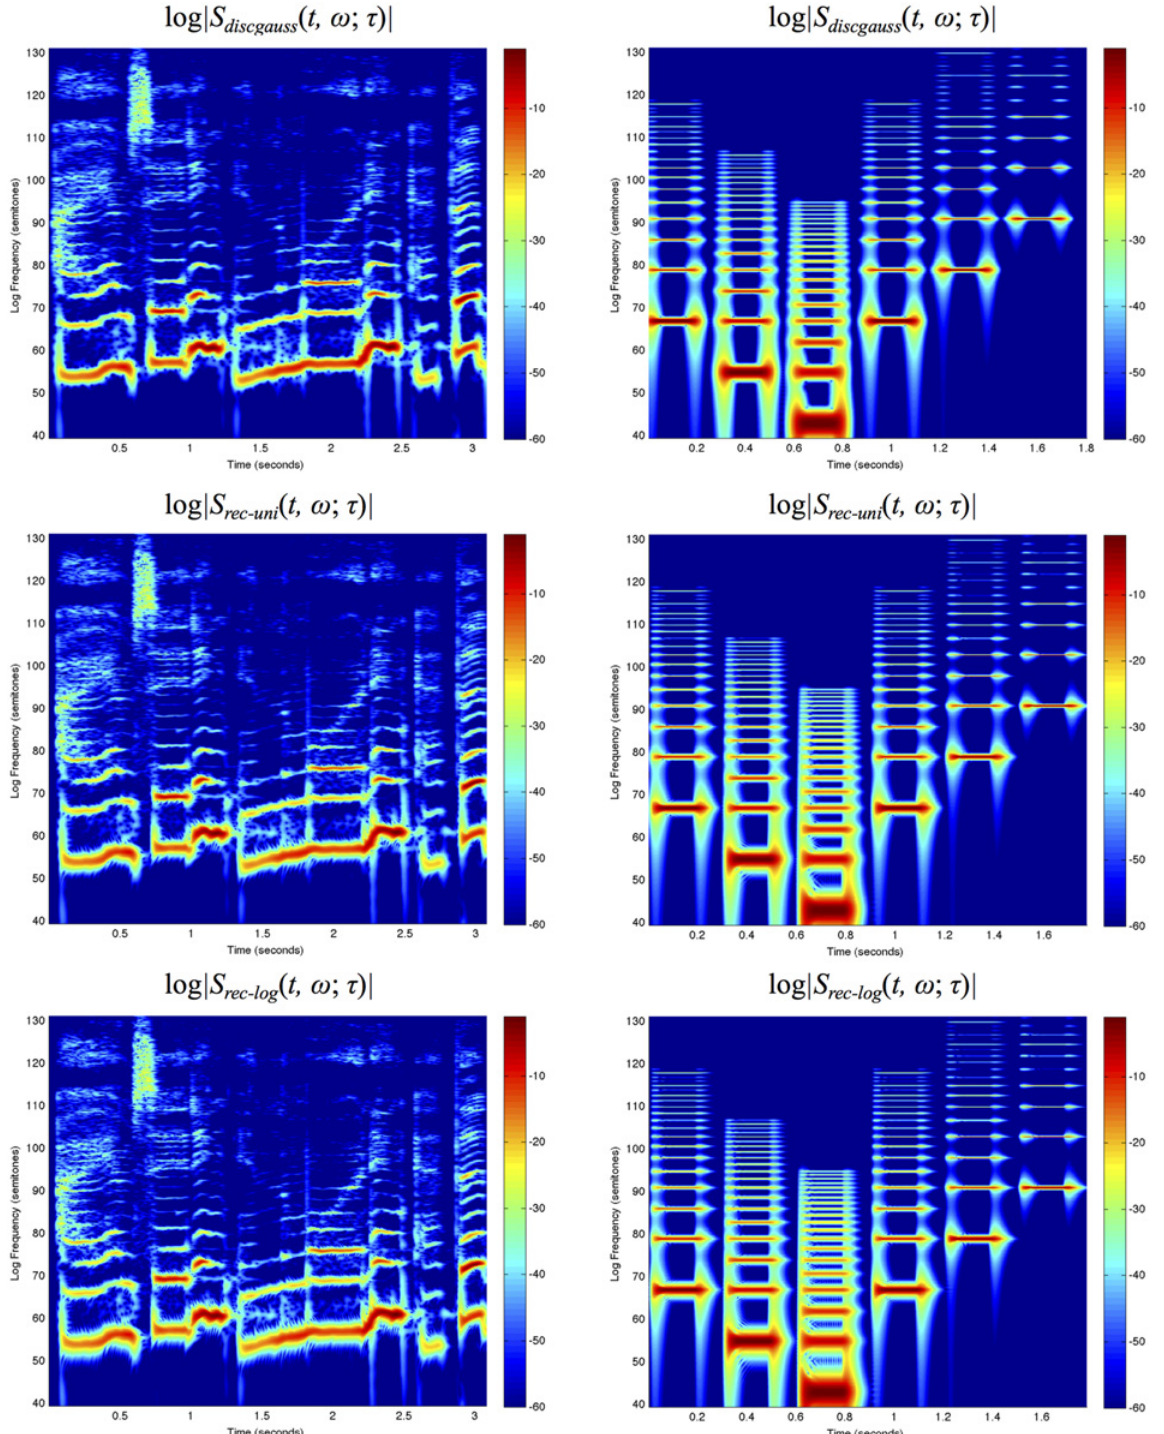
ffiffiffiffi p ¼ ¼ 20 ms computed using different temporal scale-space concepts for (left t Fig 7. Spectrograms with a fixed temporal window scale s t column) the first 3 seconds of “ Tom ’ s diner ” by Suzanne Vega with the lyrics “ I am sitting in the morning at the ... ” and (right column) a synthetic signal containing harmonic spectra with different fundamental frequencies over a logarithmic frequency scale from 80 Hz to 16 kHz using 48 frequency levels per octave: (top row) the discrete analogue of the Gaussian kernel, (middle row) a cascade of seven time-causal recursive filters having a uniform distribution of the temporal scale levels and (bottom row) a cascade of seven time-causal recursive filters having a logarithmic